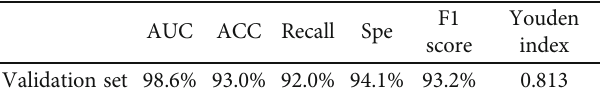
Table 5: Classi fi cation performance on the validation set using di ff erent evaluation